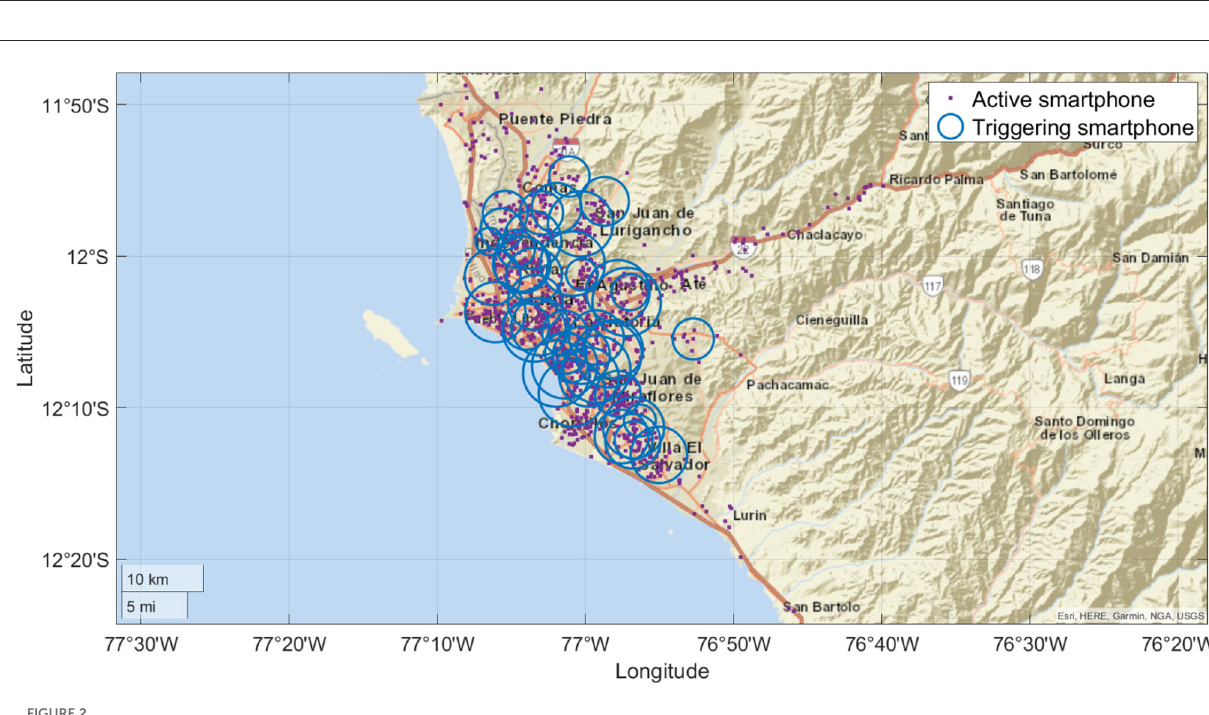
respectively, which are realistic values for an error on the triggering time. Of the remaining 30% of smartphones which do not trigger, 6% are made triggering at random with a triggering time